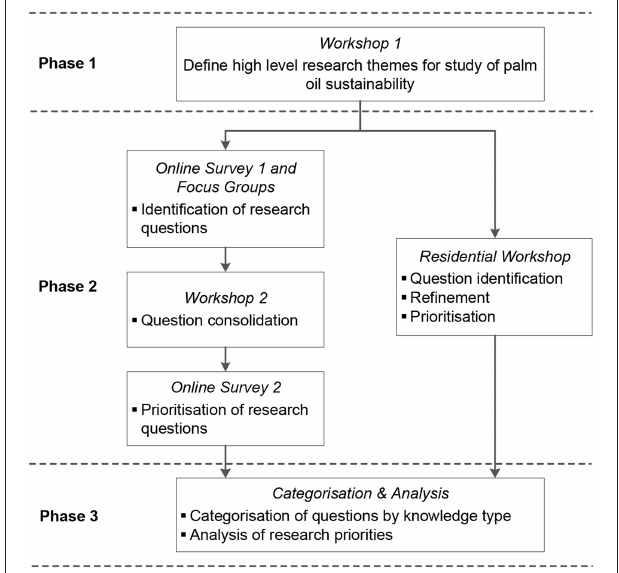
FIGURE 2 | Workflow of steps taken to generate, prioritize, and analyse research